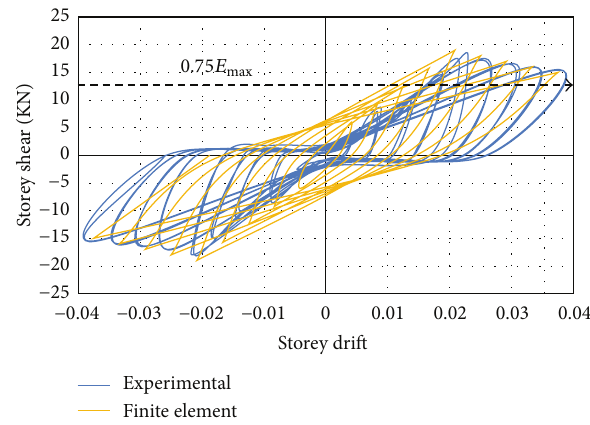
Figure 9: An experimental and finite element hysteresis response comparison for the DCL-CONVEN specimen.